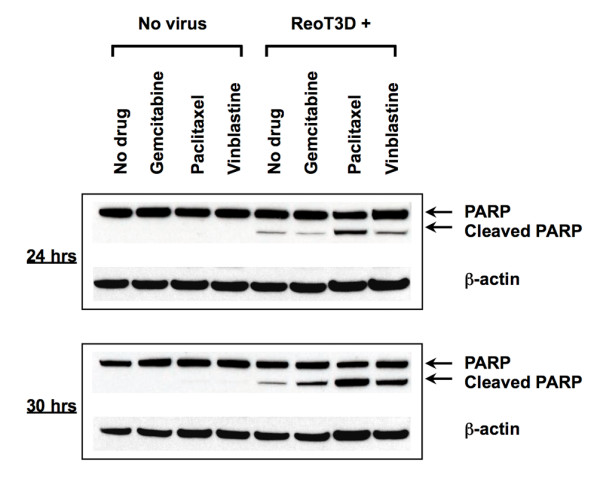
Western blot analysis of poly (ADP-ribose) polymerase (PARP) cleavage in cell lysates obtained from NCI-H460 cultured for 24 to 30 hrs after infection with ReoT3D (MOI = 20) in the absence or presence of gemcitabine (1 μM), paclitaxel (1 μM) or vinblastine (0.1 μM). Shown are the full-length PARP (116 kDa) and the larger fragment (89 kDa) of apoptotically cleaved products, as well as β-actin used as a loading control. Results are representative of 2 separate experiments.